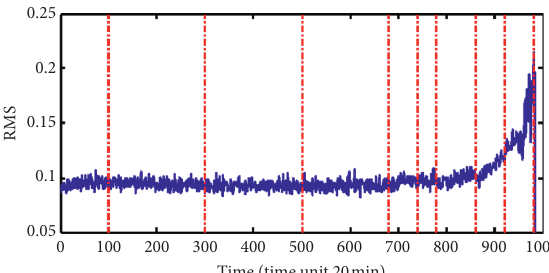
Figure 3: Bearing PDA based on RMS for the whole life time (the vertical red line corresponds to the monitor runtime moment).